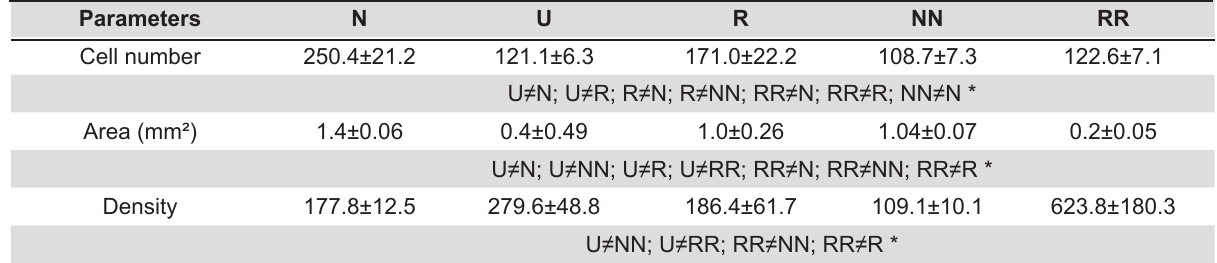
Table 4- Immunostaining of insulin receptor (IR) in the subchondral bone (mean±SD). SD=Standard Deviation